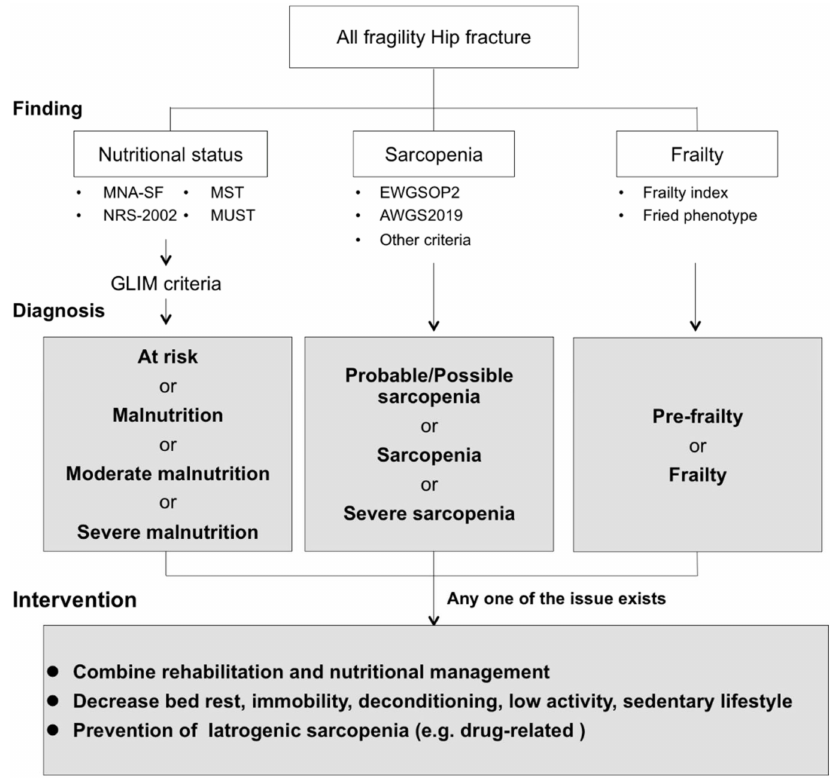
Figure 2. The specific strategies of geriatric nutritional evaluation and advanced intervention for patients with fragility hip fracture. Abbreviations: MNA-SF, Mini Nutritional Assessment-Short Form; MST, Malnutrition Screening Tool; NRS-2002, Nutrition Risk Screening 2002; MUST, Malnutrition Universal Screening Tool; EWGSOP, European Working Group on Sarcopenia in Older People; AWGS, Asian Working Group for